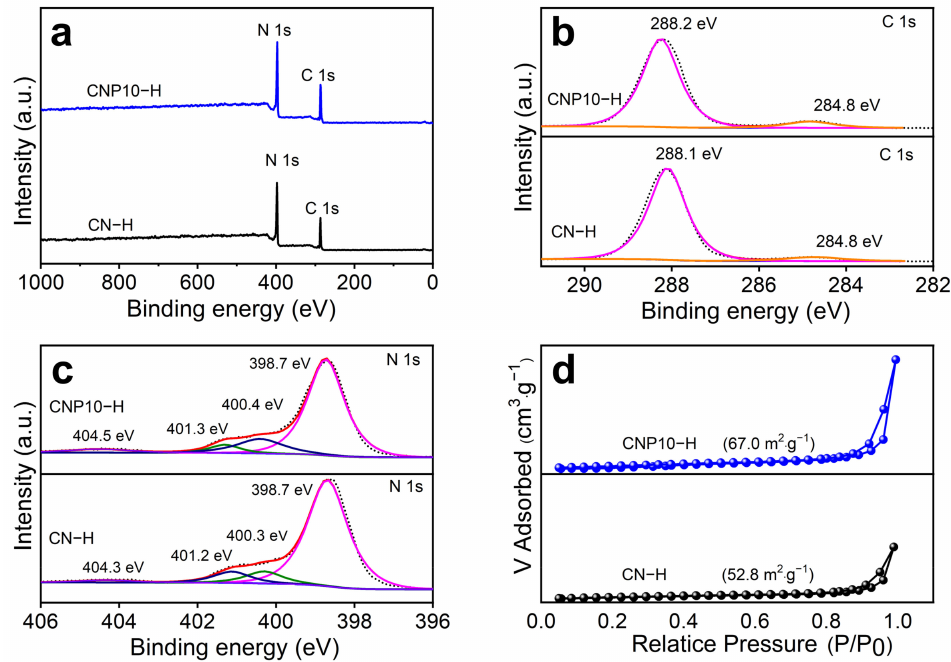
Figure 7. ( a ) XPS-survey spectra, ( b ) C 1 s high-resolution spectra, and ( c ) N 1 s high-resolution spectra of CN-H and CNP10-H; ( d ) N 2 adsorption-desorption isotherm of CN-H and